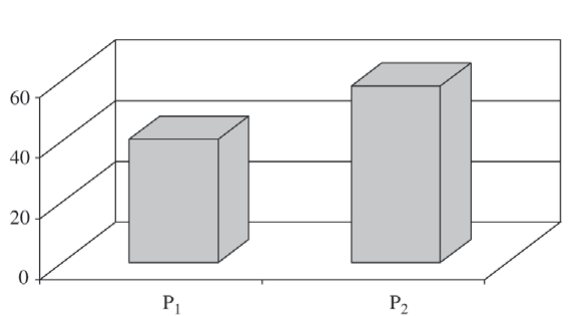
Figura 3. Factor momento de pulimento (P).